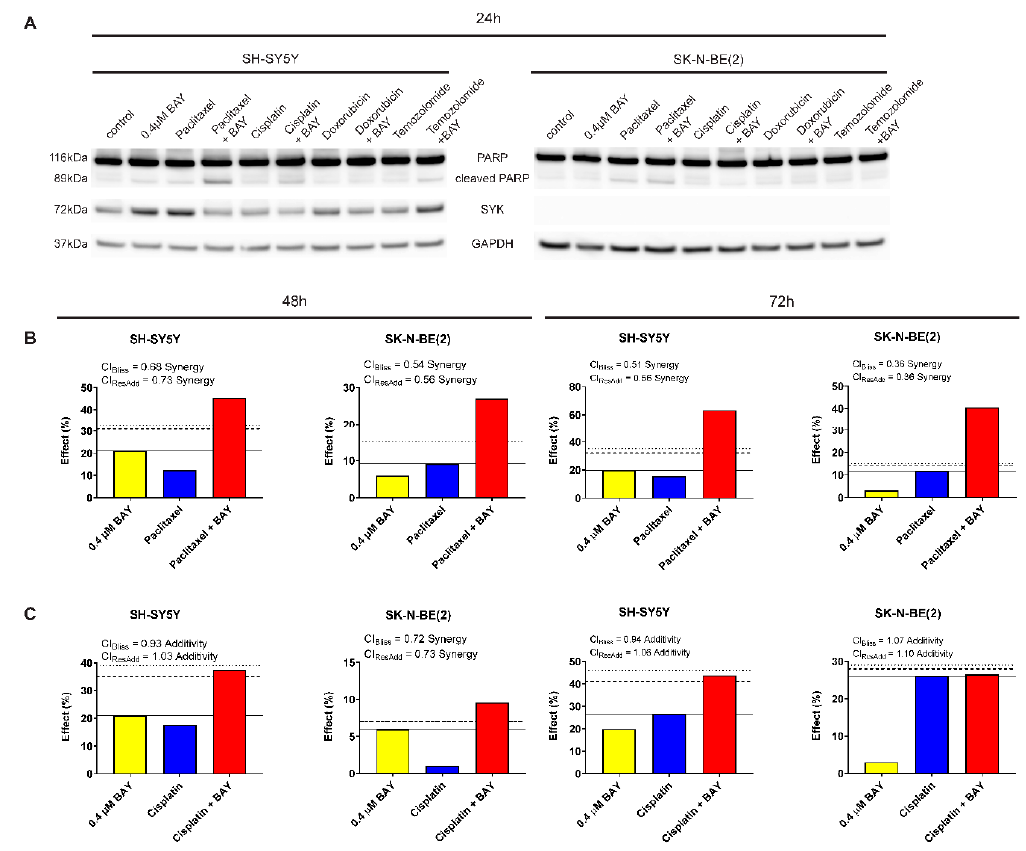
Figure 7. The selective SYK inhibitor BAY 61-3606 enhances the effect of chemotherapeutic drugs in neuroblastoma cells. ( A ) PARP cleavage and SYK expression were determined by western blot after 24 h monotherapy or combinations of 0.4 μ M BAY 61-3606, 20 nM paclitaxel, 5 nM doxorubicin, 100 μ M temozolomide and cisplatin (1 μ M or 3 μ M for SH-SY5Y and SK-N-BE(2), respectively). Illustration of drug combination effects for 0.4 μ M BAY 61-3606 and paclitaxel ( B ) as well as 0.4 μ M BAY 61-3606 and cisplatin ( C ) in SH-SY5Y and SK-N-BE(2) cells after 48 h and 72 h treatment. The continuous horizontal line indicates the effect of the highest single agent, the dashed line denotes